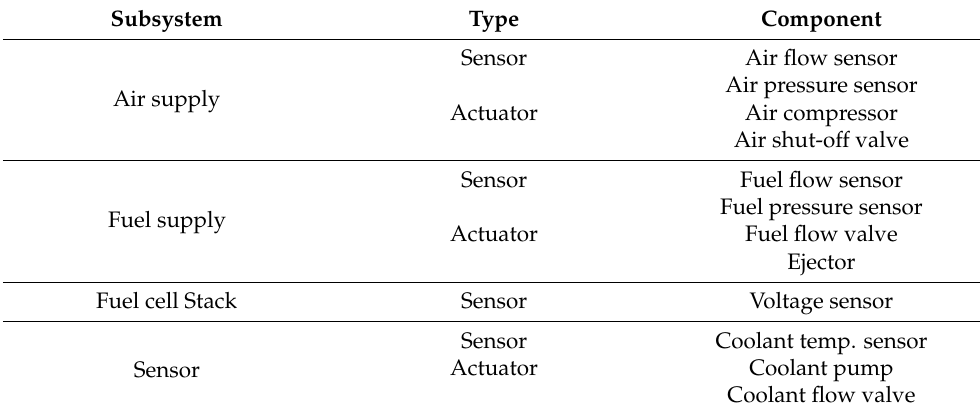
Table 1. List of sensors and actuators in